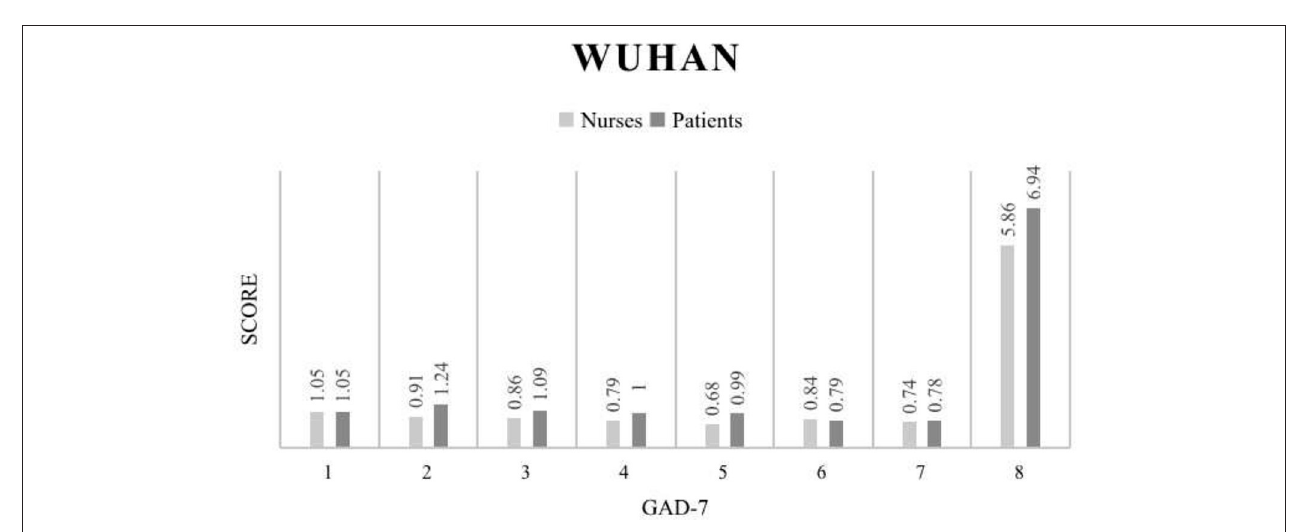
FIGURE 2 | PHQ-9 score results for the Non-Hubei region.